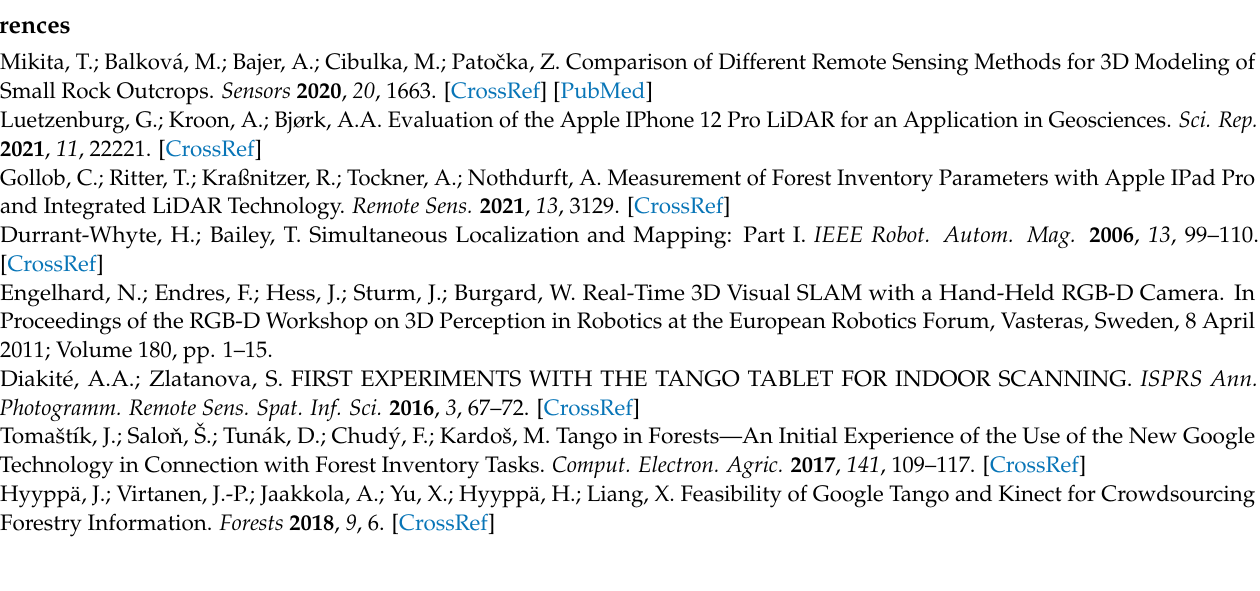
Figure A6. C2C histograms between smartphone point clouds and reference point clouds: laboratory room point cloud with 1 cm resolution ( a ), 1.5 cm resolution ( b ) and 2 cm resolution ( c ); Doric column remains point cloud with 1 cm resolution ( d ), 1.5 cm resolution ( e ) and 2 cm resolution ( f ).